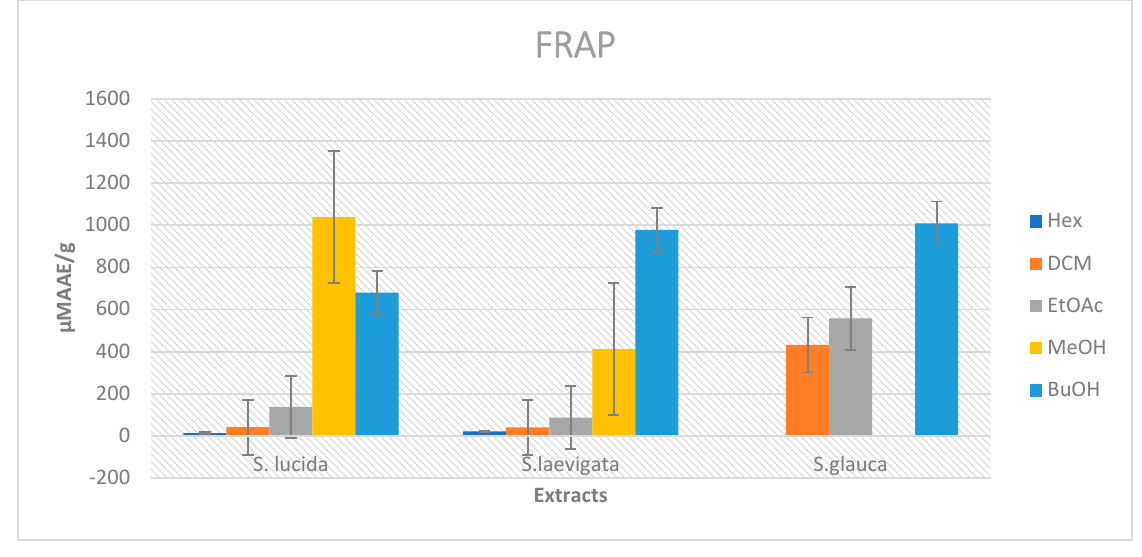
Figure 3. Bar chart of FRAP values of extracts from S. lucida, S. laevigata, and S. glauca. Table 2. Ferric ion reducing power (FRAP) and Trolox equivalent antioxidant capacity (TEAC) activities of S. lucida, S. laevigata, and S. glauca extracts. FRAP ( µ M AAE/g) TEAC ( µ M